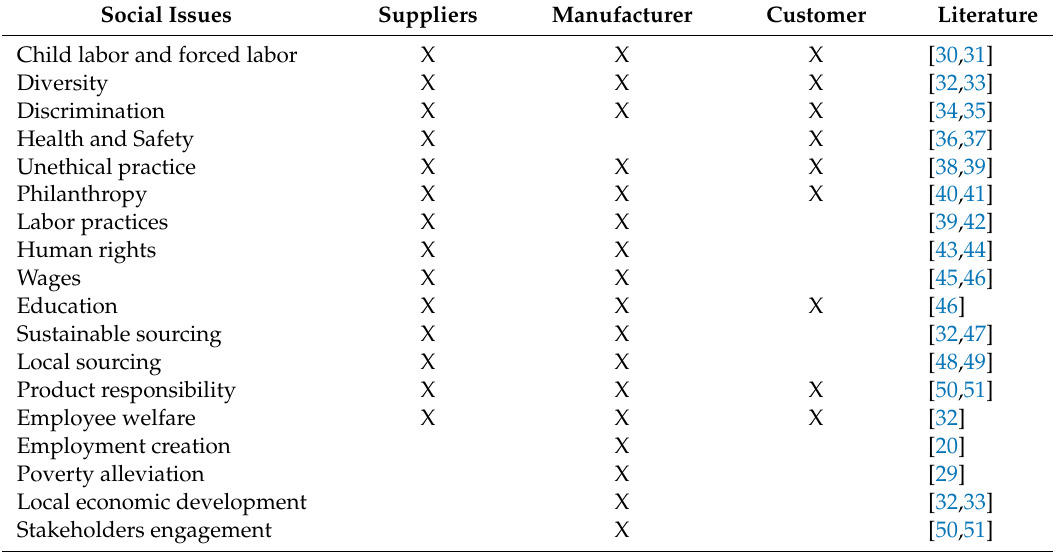
Table 1. List of supply chain social issues identified through